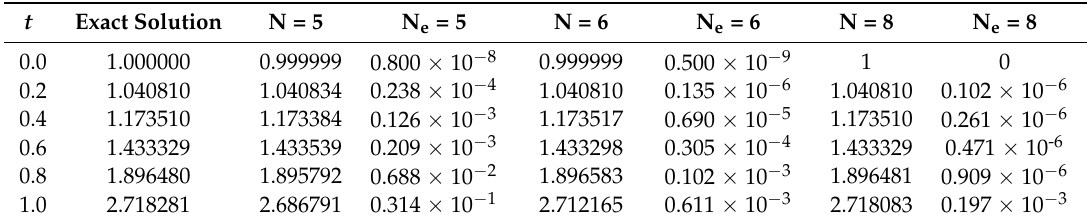
Table 1. Numerical result for approximate solution of y 1 ( t ) in Example 2.